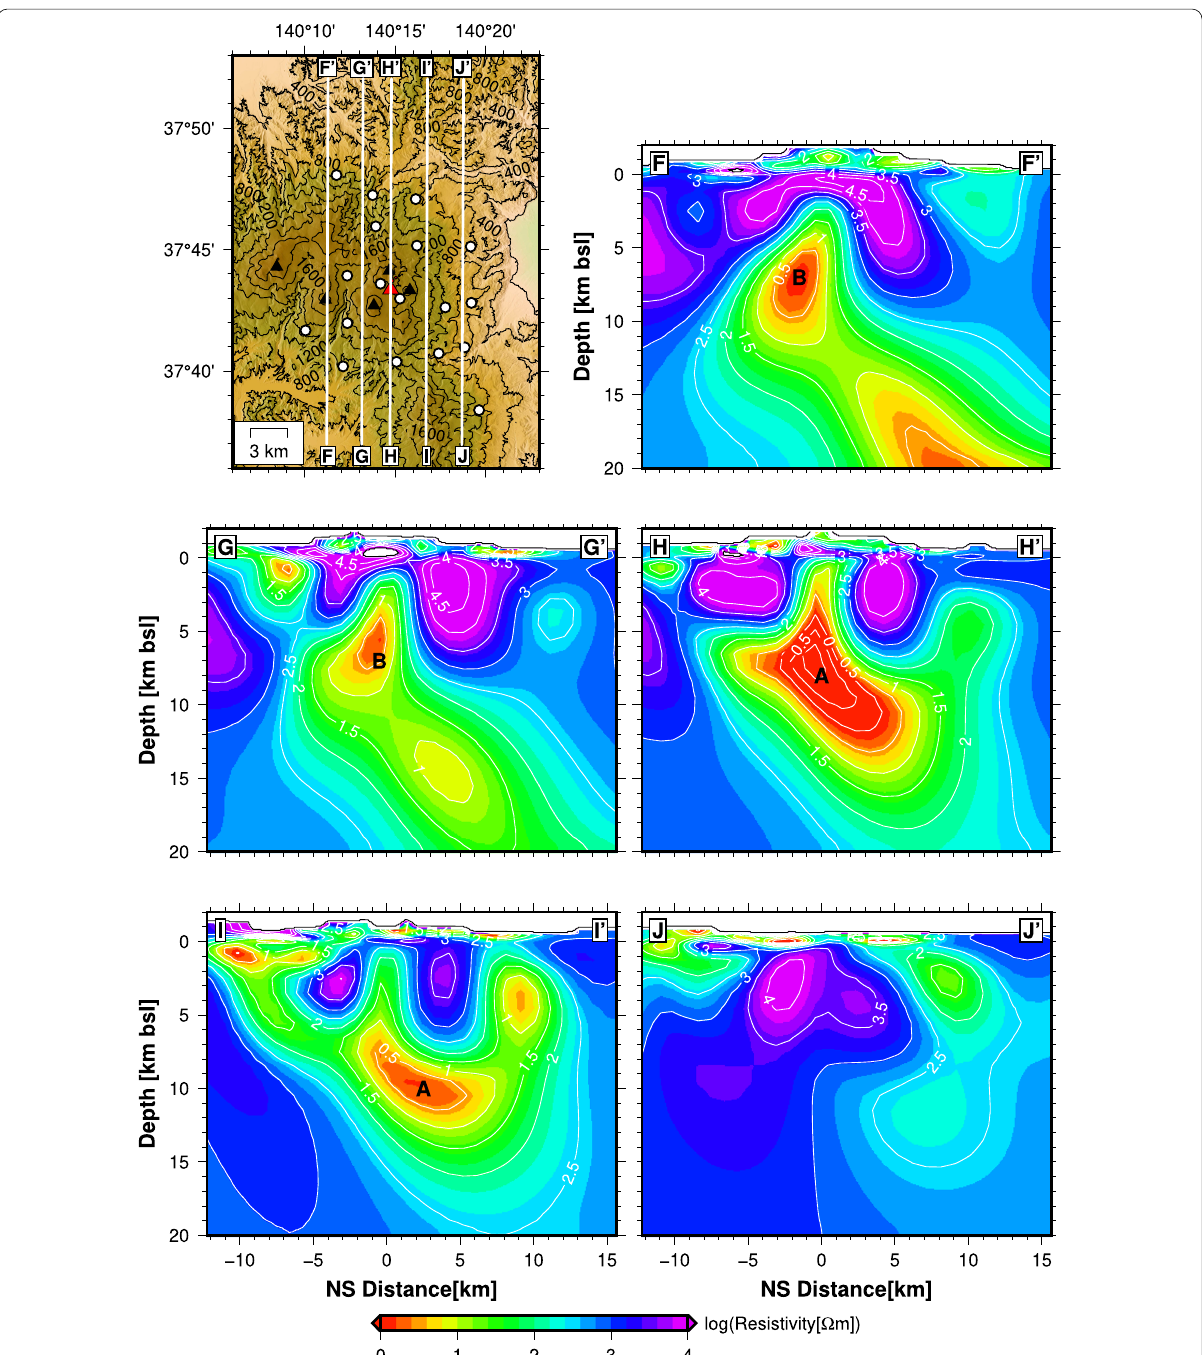
Fig. 7 Vertical profile of the final resistivity model in the N–S direction. The origin of the N–S coordinate is fixed at Oana Crater. Other features are the same as those in Figs. 5 and